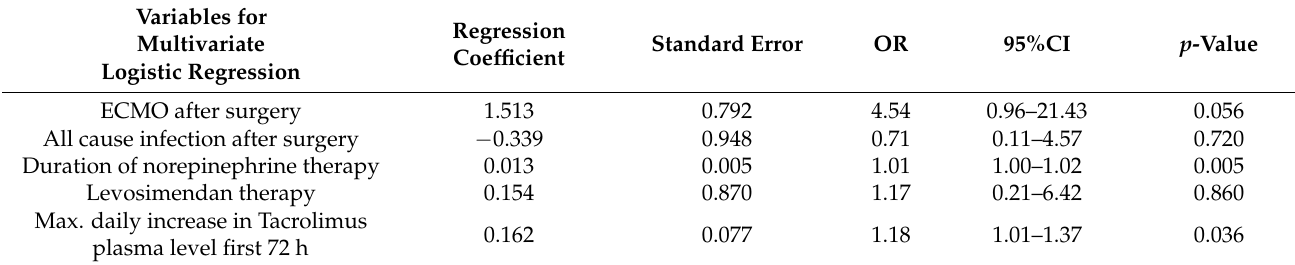
Table 3. Multivariate logistic regression for variables predicting acute kidney injury requiring renal replacement therapy after heart